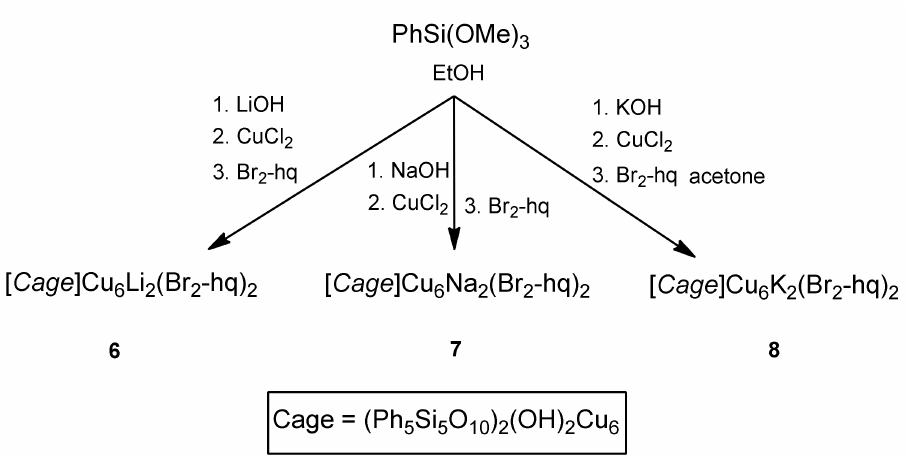
Scheme 4. General scheme of the synthesis of CuLi- ( 6 ), CuNa- ( 7 ), and CuK-based ( 8 )